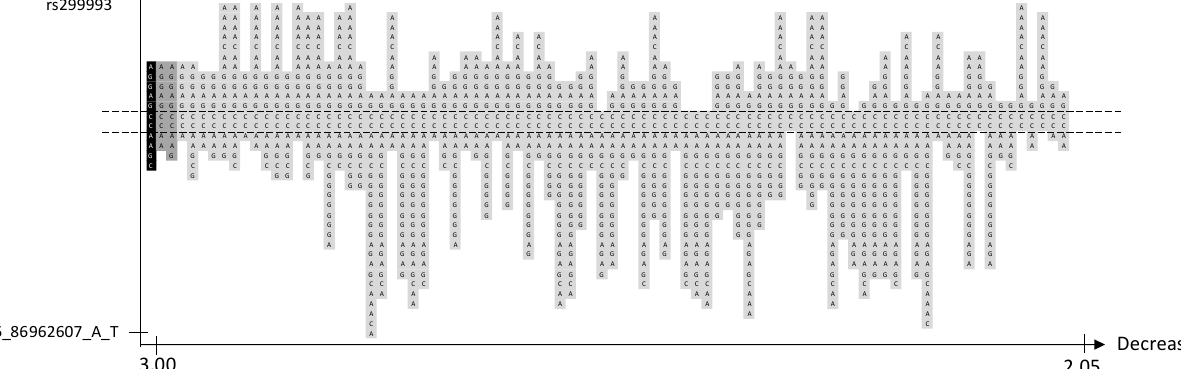
Figure 4. Chromosome 16, 3 significant and 85 borderline significant haplotypes sorted by OR. The haplotype with the lowest p -value is marked in black, other significant haplotypes in dark gray and borderline significant in light gray. SNP position is on the y -axis. The corresponding OR is on the x -axis. The dashed lines indicate the proximal and distal SNP that are shared by the significant and borderline significant haplotypes.